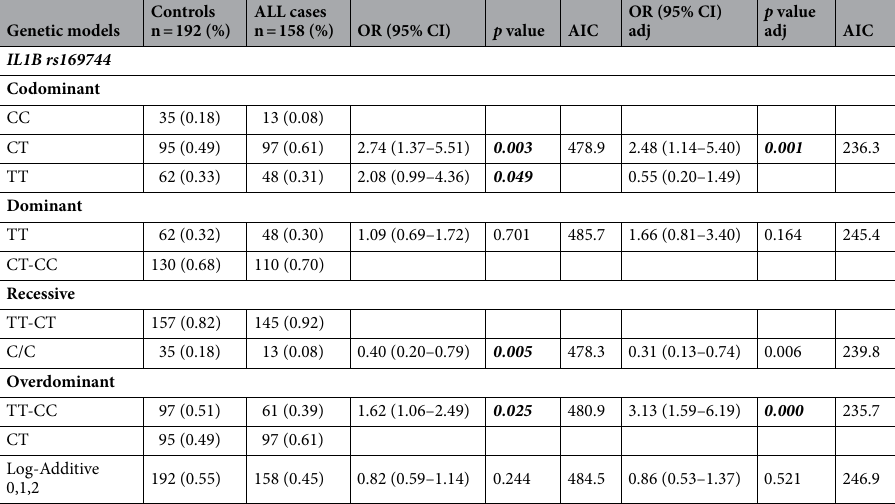
Table 2. Multivariate analysis adjusted for sex and age for the association of single-variant polymorphisms (SNVs) in study with acute lymphoblastic leukemia. Adjusted for sex and age ( p value adj , OR adj ); OR: Odds Ratio; p value: < 0.05; 95% confidence interval; AIC: Akaike information criterion value.